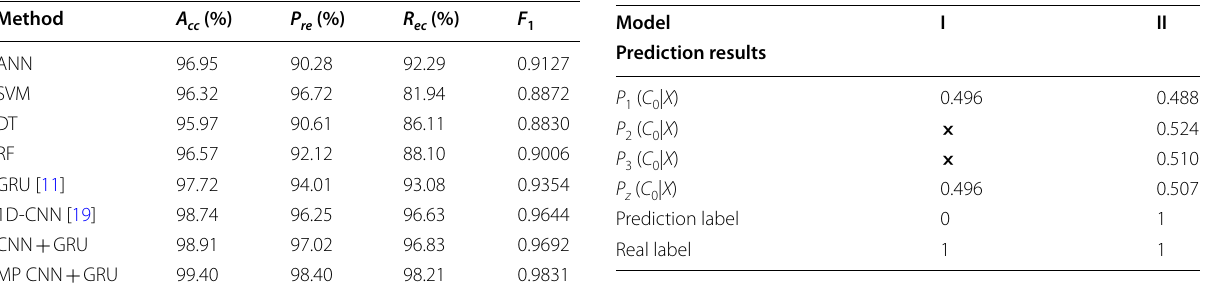
Table 2 TSA performance on the IEEE 39-bus system